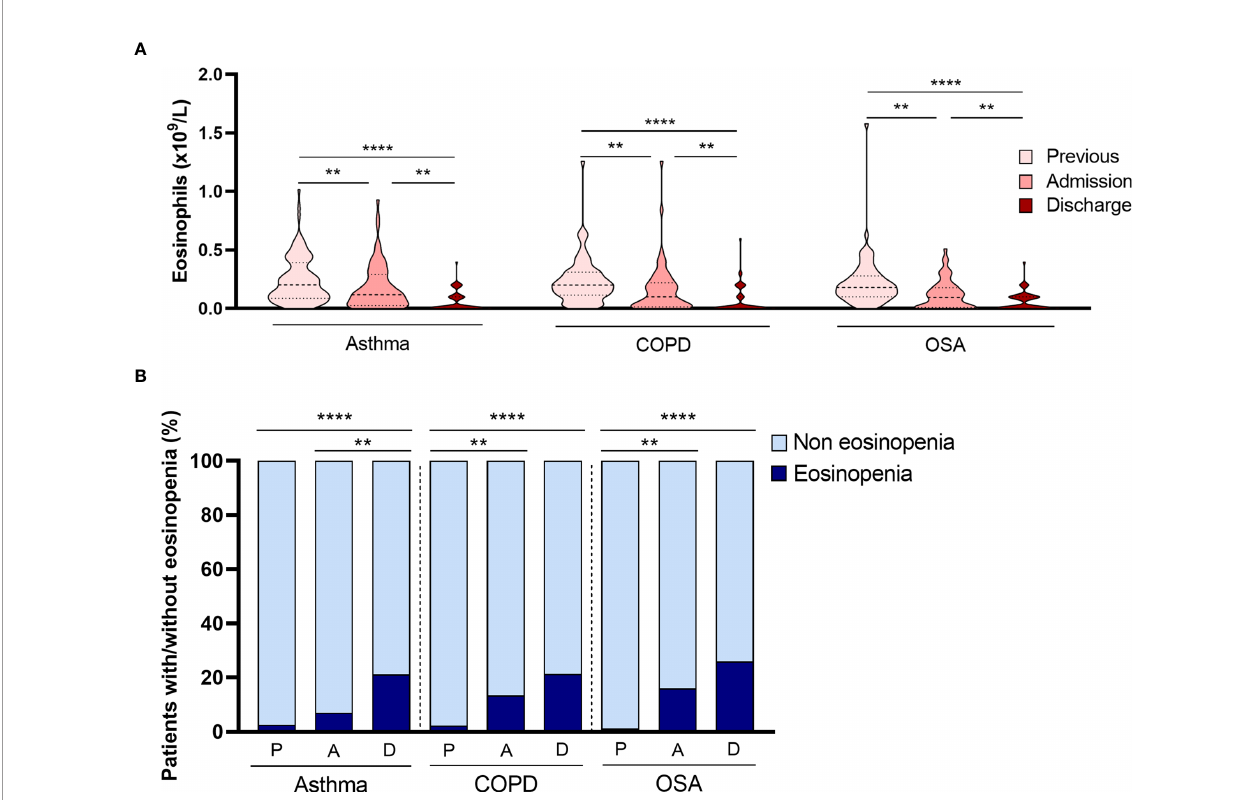
( Figure 4C ). Lymphocytes on admission were signi fi cantly higher than lymphocytes at discharge in both the eosinopenia and non- eosinopenia groups ( Figure 4C ), suggesting a correlation between lymphocyte and eosinophil counts ( Figure 4D ). Also, levels of